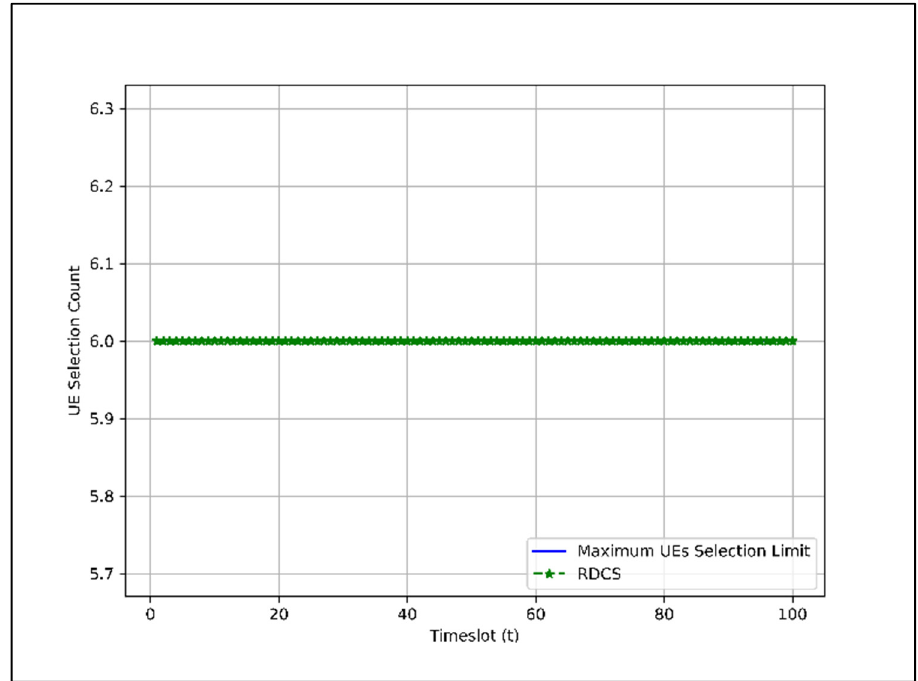
Figure 8. Total UEs selection count under RDCS for 100 timeslots.